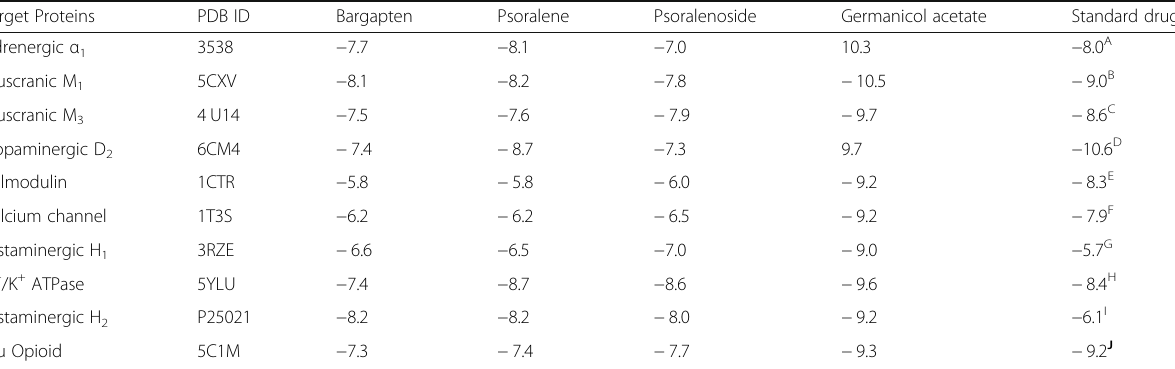
Table 4 E-values (Kcal/mol) of best docked poses of bergapten, psoralene, psoralenoside, germanicol acetate and standard drugs against targets: adrenergic α 1 receptor, muscranic M 1 , muscranic M 3 , dopaminergic D 2 , calmodulin, mu-opioid, voltage gated L-Type